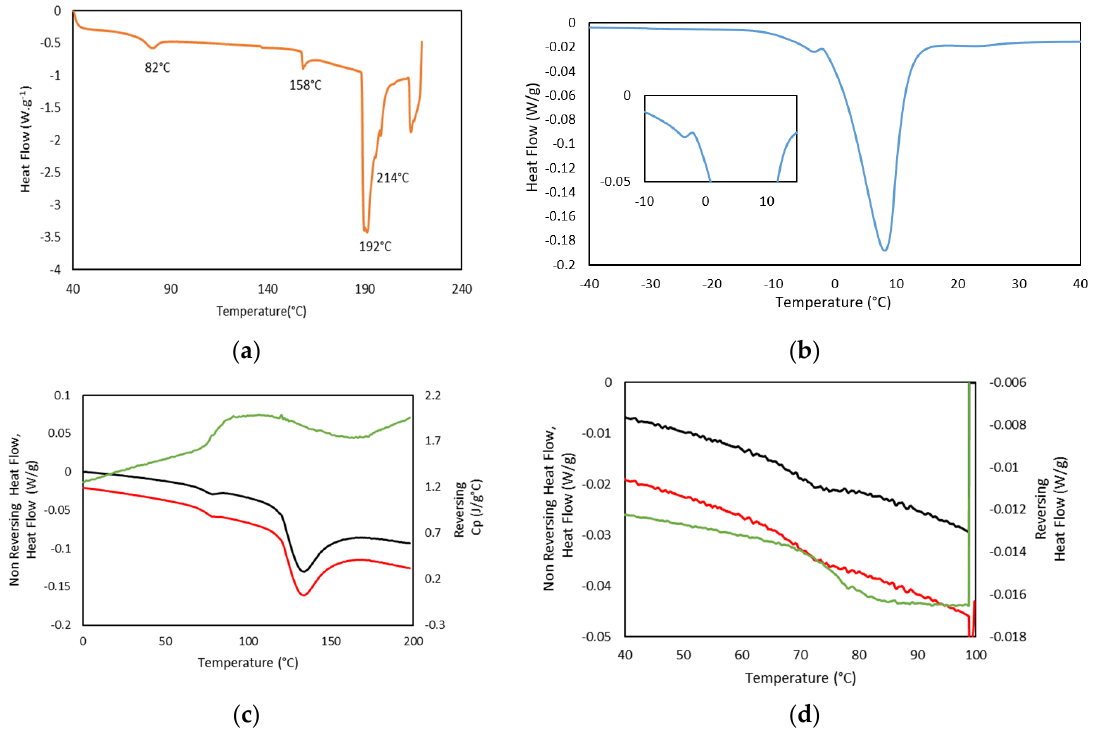
Figure 9. ( a ) DSC thermogram of Dry GE, heating ramp at 5 °C·min − 1 , ( b ) DSC Thermogram of 25GE, heating ramp at 1 °C·min − 1 , ( c ) MDSC Dry GE in the Rev Cp (green color), Non Reversing Heat Flow (black color) and Heat Flow (red color), heating ramp, at 1 °C/min, ( d ) MDSC Dry GE in the Rev Heat Flow (green color), Non Reversing Heat Flow (black color) and Heat Flow (red color), second heating ramp, at 0.5 °C·min − 1 .